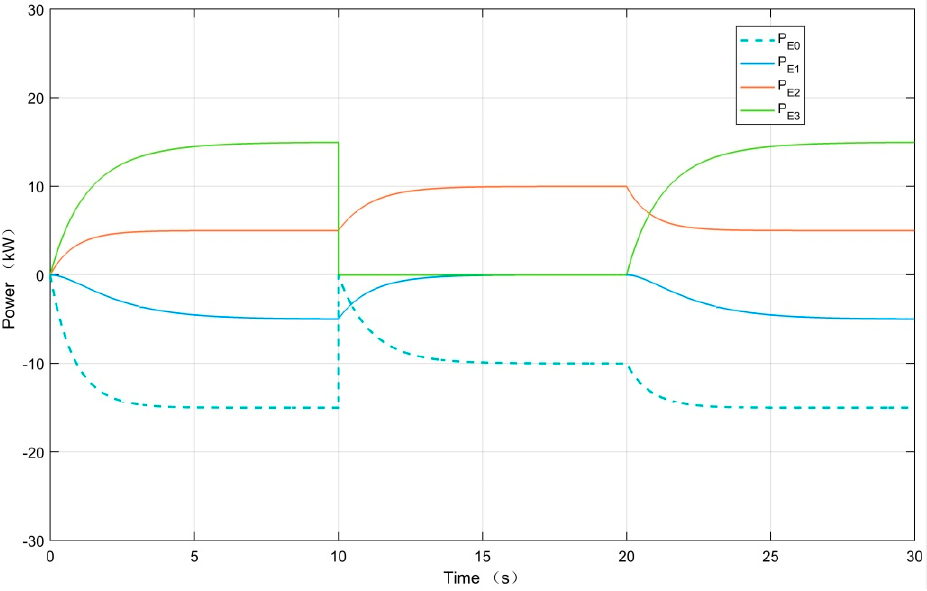
Figure 20. Exchange power in modules.